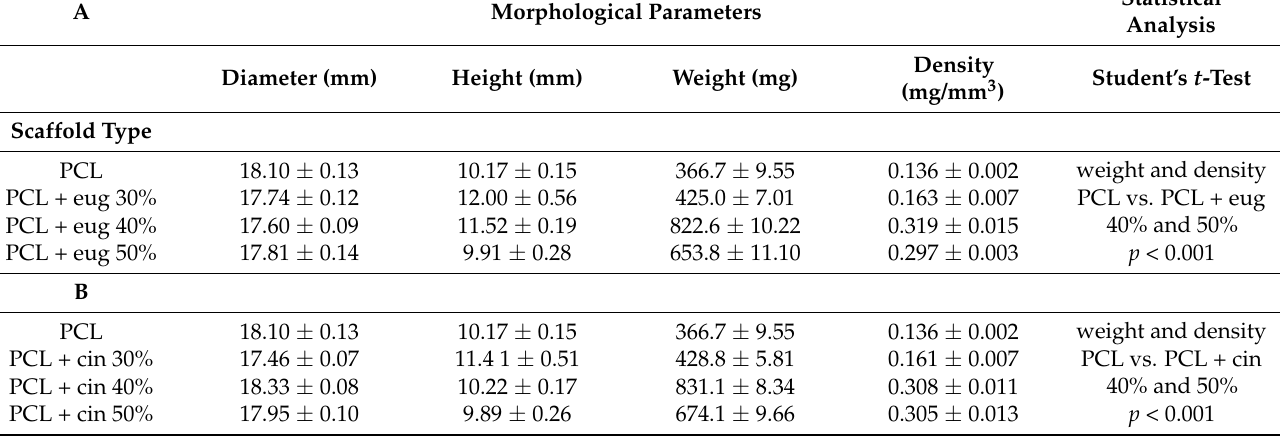
Table 2. Morphological characteristics (reported as mean ± standard error of the mean) of the PCL- based scaffolds (obtained with NaNO 3 ) added with increasing (from 30 to 50%) concentrations of eugenol ( A ) or cinnamon oil ( B ).